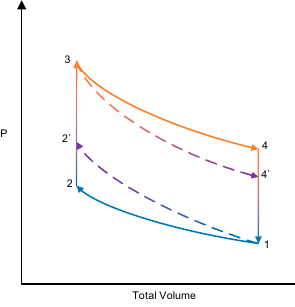
Figure 2. Pressure volume (PV) diagram of the Stirling engine ideal adiabatic cycle 1-2`-3-4` and the ideal isothermal cycle 1-2-3-4.